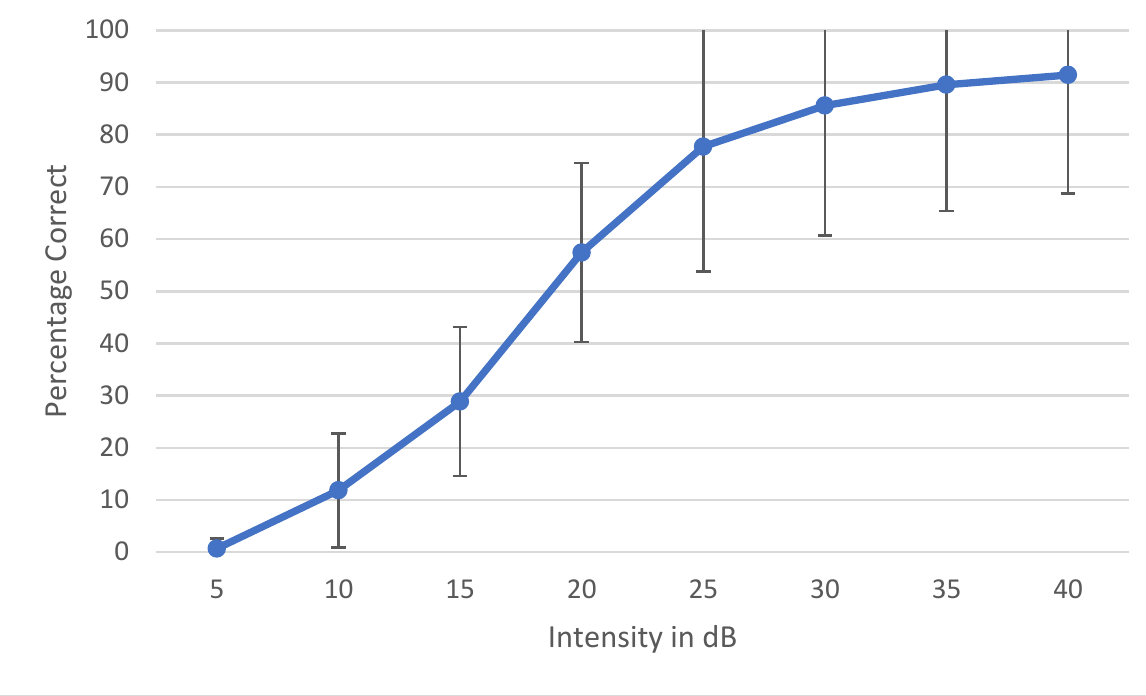
Figure 3. Average psychometric properties for the Maltese AAST words in adults in quiet.